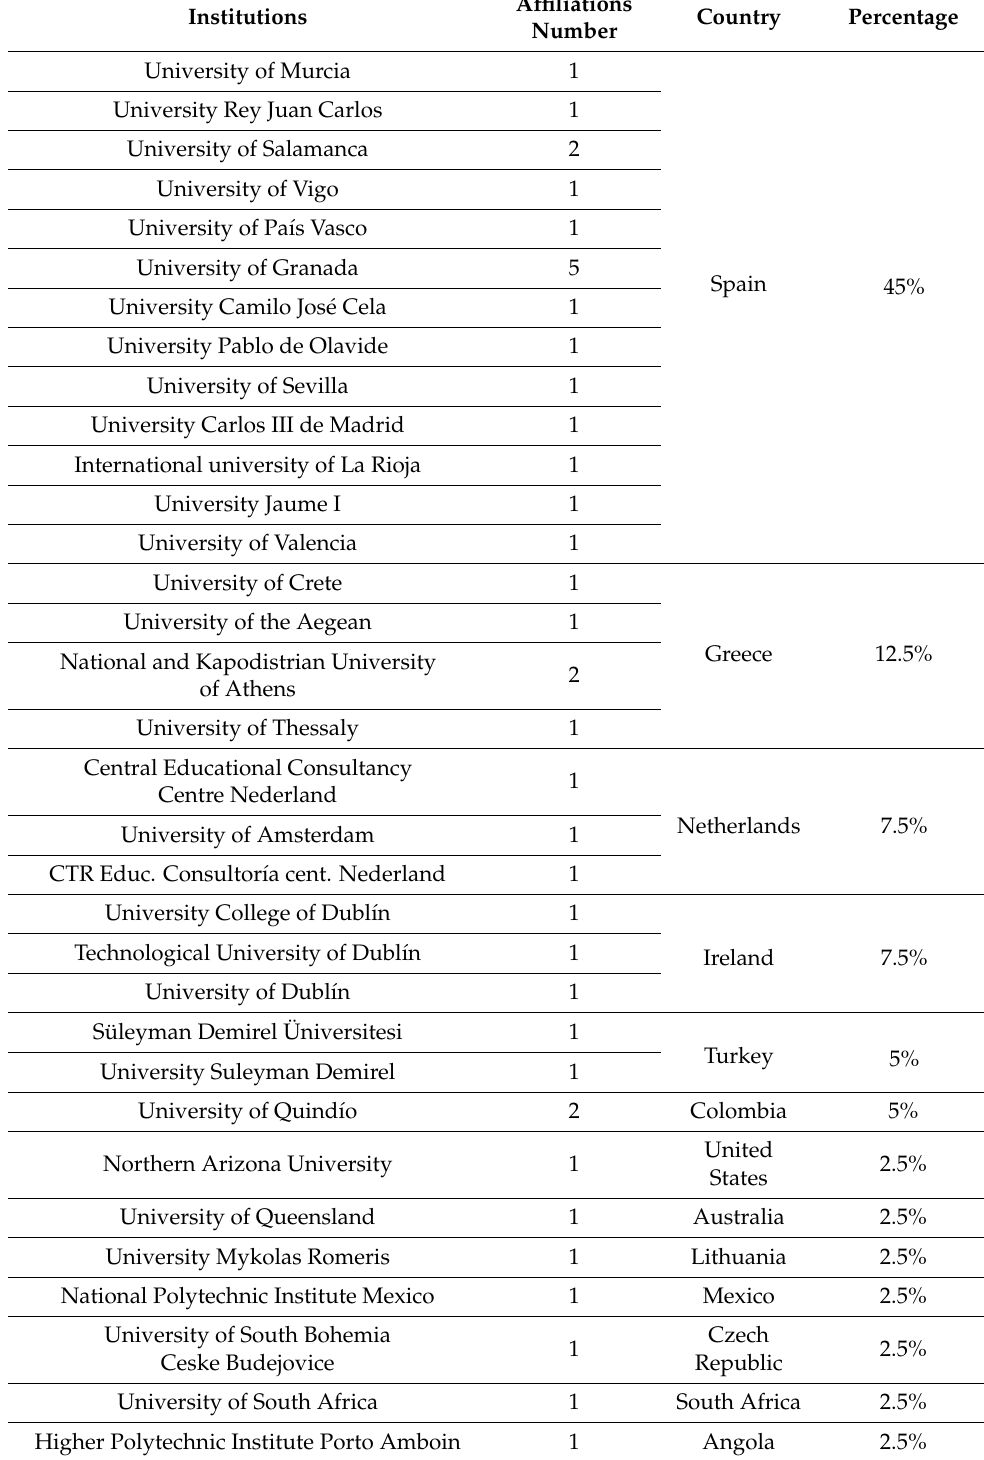
Table 2. Institutions with which the authors of the articles listed are